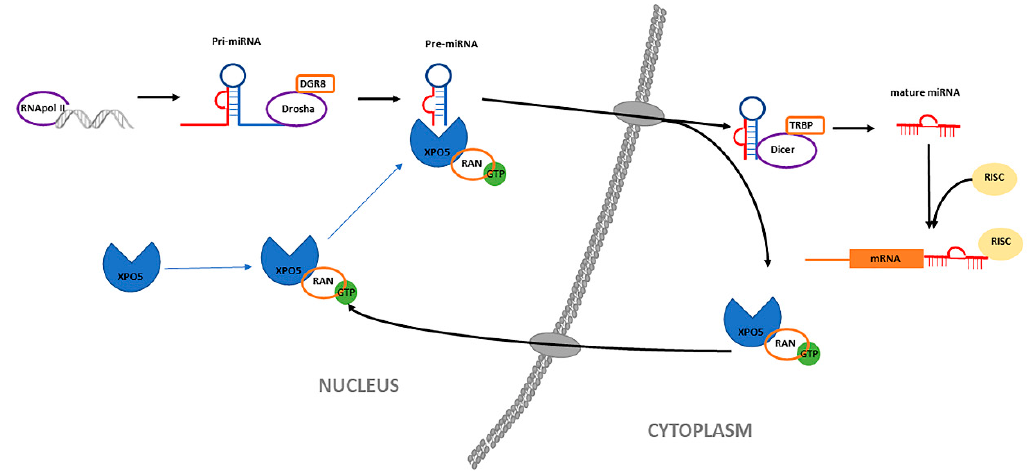
Figure 1. Diagram of miRNA biogenesis. In the nucleus, miRNA that are transcribed by RNA polymerase II or III as primary transcripts (pri-miRNA). The enzyme Drosha and its cofactor DGCR8 / Pasha then cut the pri-miRNA molecule to form a pre-miRNA. This pre-miRNA is actively transported from the nucleus to the cytoplasm by the nuclear transport receptor Exportin 5 (XPO5) in a Ran-GTP protein dependent manner by XPO5. In the cytoplasm, the pre-miRNA is cut by a second enzyme called Dicer, until the formation of a mature and short double-stranded miRNA molecule. The miRNA duplex unwinds, and is incorporated into the RISC protein